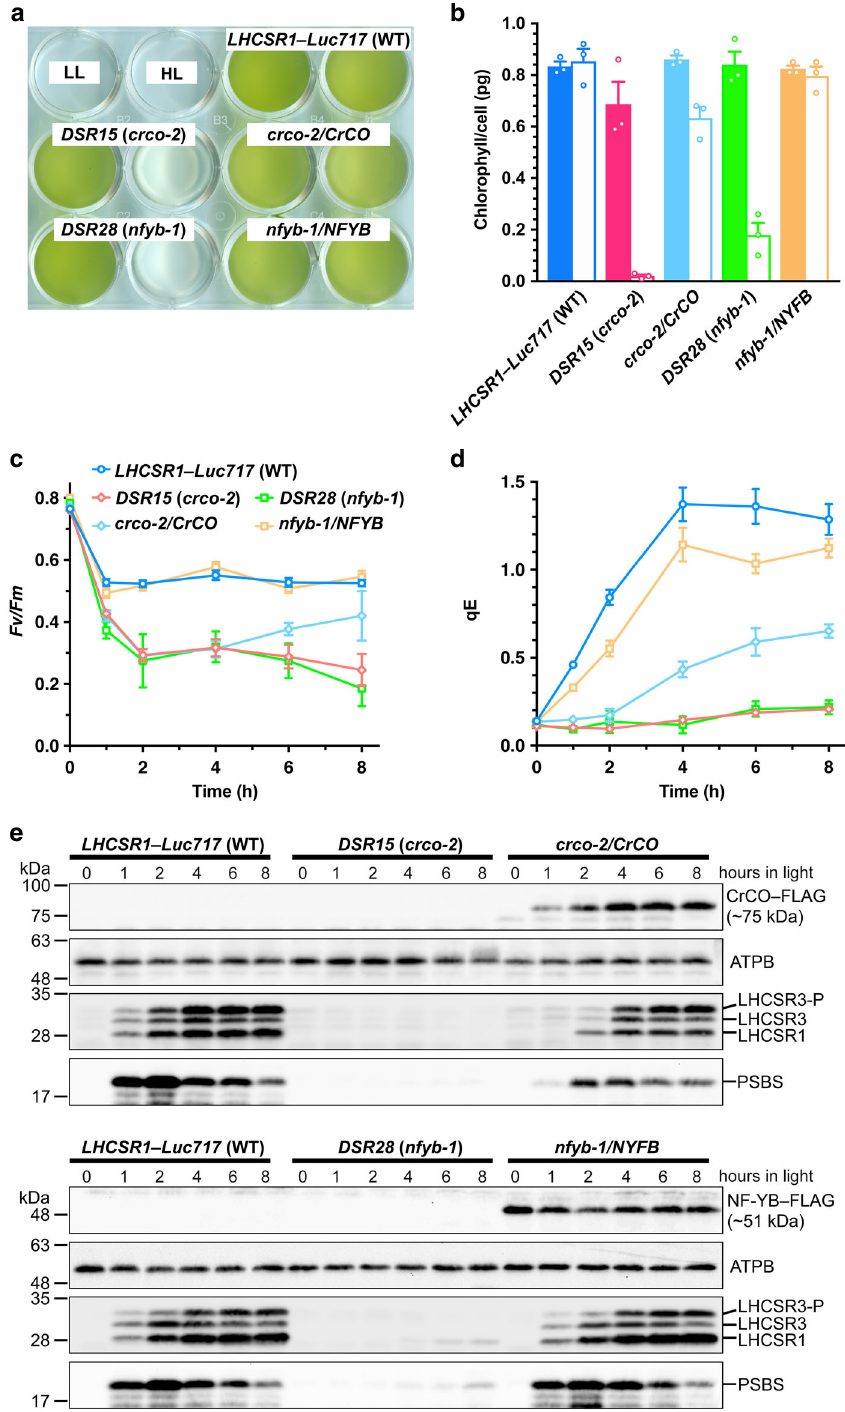
Fig. 1 CrCO and NF-YB are crucial for photoprotection. a The bleaching phenotypes of the reference strain ( LHCSR1 – Luc717 ) and the DSR mutants visualized in multiwell plates. Representative cell cultures treated with low light (LL; left wells) or high light (HL; right wells). Concentrations of the cultures were adjusted to 1.0 × 10 7 cells/mL. b Chlorophyll content per cell after LL (closed bar) or HL (open bar) treatment of the cells shown in a . c Maximum quantum yield of photosystem II (Fv/Fm) during HL treatment. d qE quenching capability during HL treatment. e Immunoblot analysis of 3xFLAG-fused proteins (CrCO – FLAG and NF-YB – FLAG in crco-2 / CrCO and nfyb-1 / NFYB , respectively), LHCSR1, LHCSR3, and PSBS during HL treatment. ATPB protein levels are shown as the loading control. The experiments were performed three times with different biological samples ( n = 3 biological replicates; mean ± S.E.M); a representative experiment is shown in e